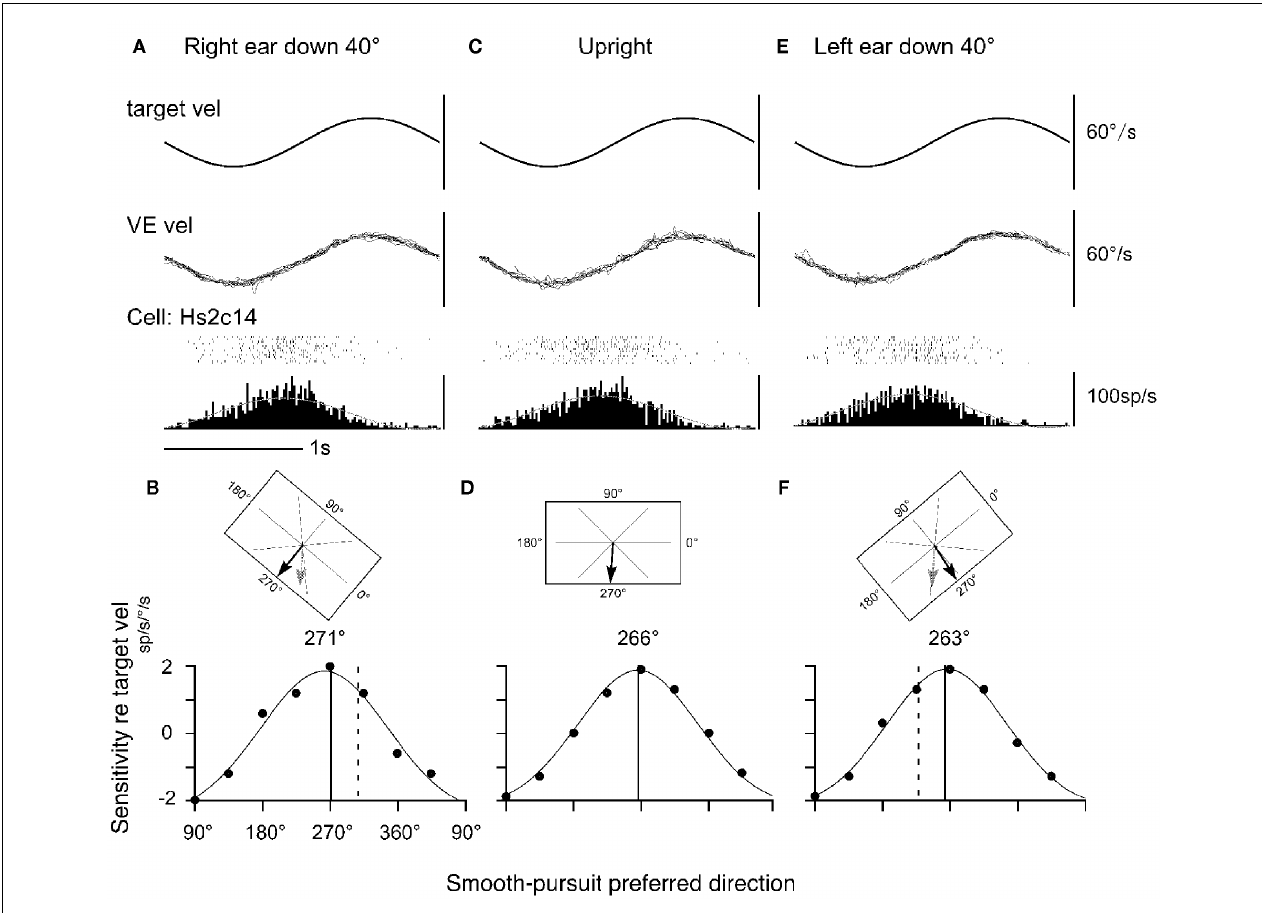
arrows. Expected preferred directions in the earth-vertical coordinates are indicated by gray arrows in (B,F) . (B,D,F ; bottom) illustrate directional tning and Gaussian fits for actual responses for each condition. Solid and dashed lines are actual and expected preferred directions, respectively. Dots indicate actual sensitivity values.VE vel indicates vertical eye velocity. Reproduced from Kurkin et al. (2007) with